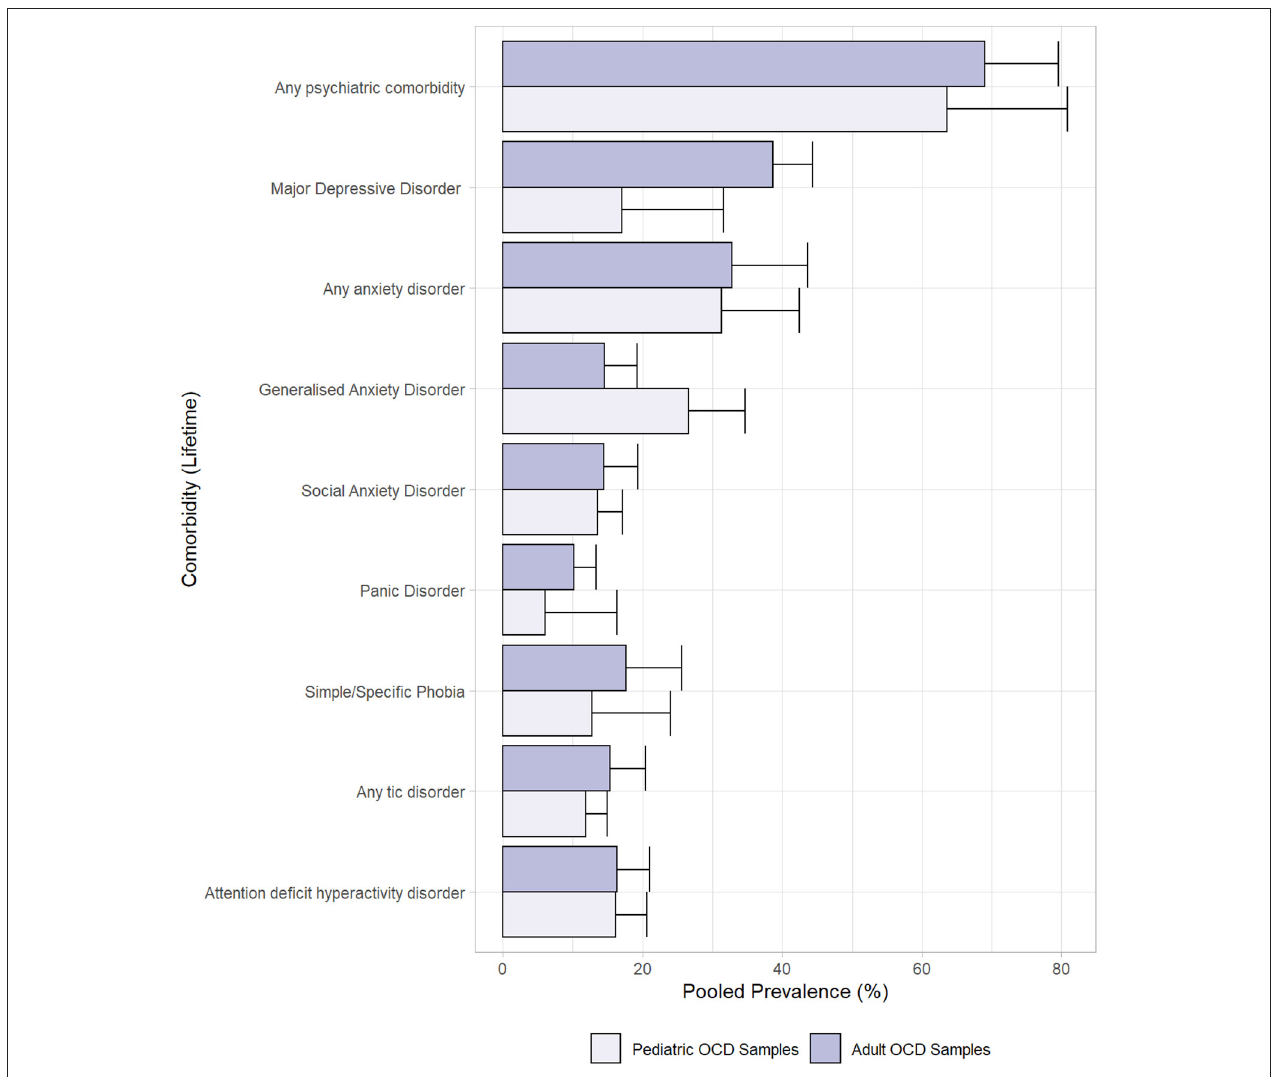
FIGURE 3 | Pooled prevalence rates by comorbidity in adult and paediatric